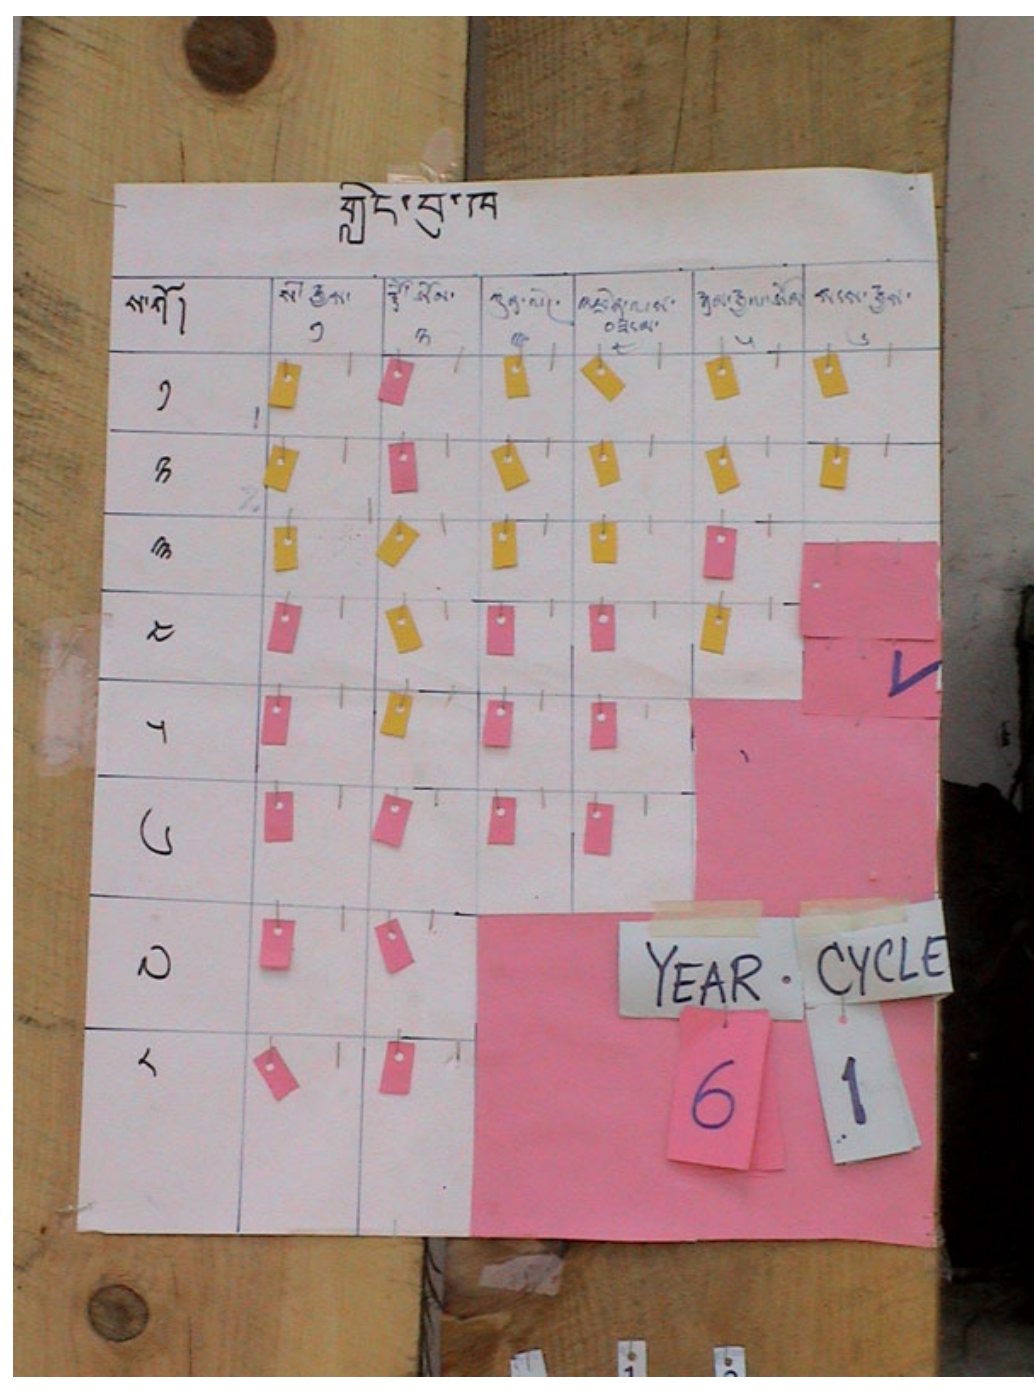
Fig. 3. The game board for one village: one column for each farmer (farmer A has 8 plots, farmer B has two plots). Yellow papers represent potato crops and pink papers represent